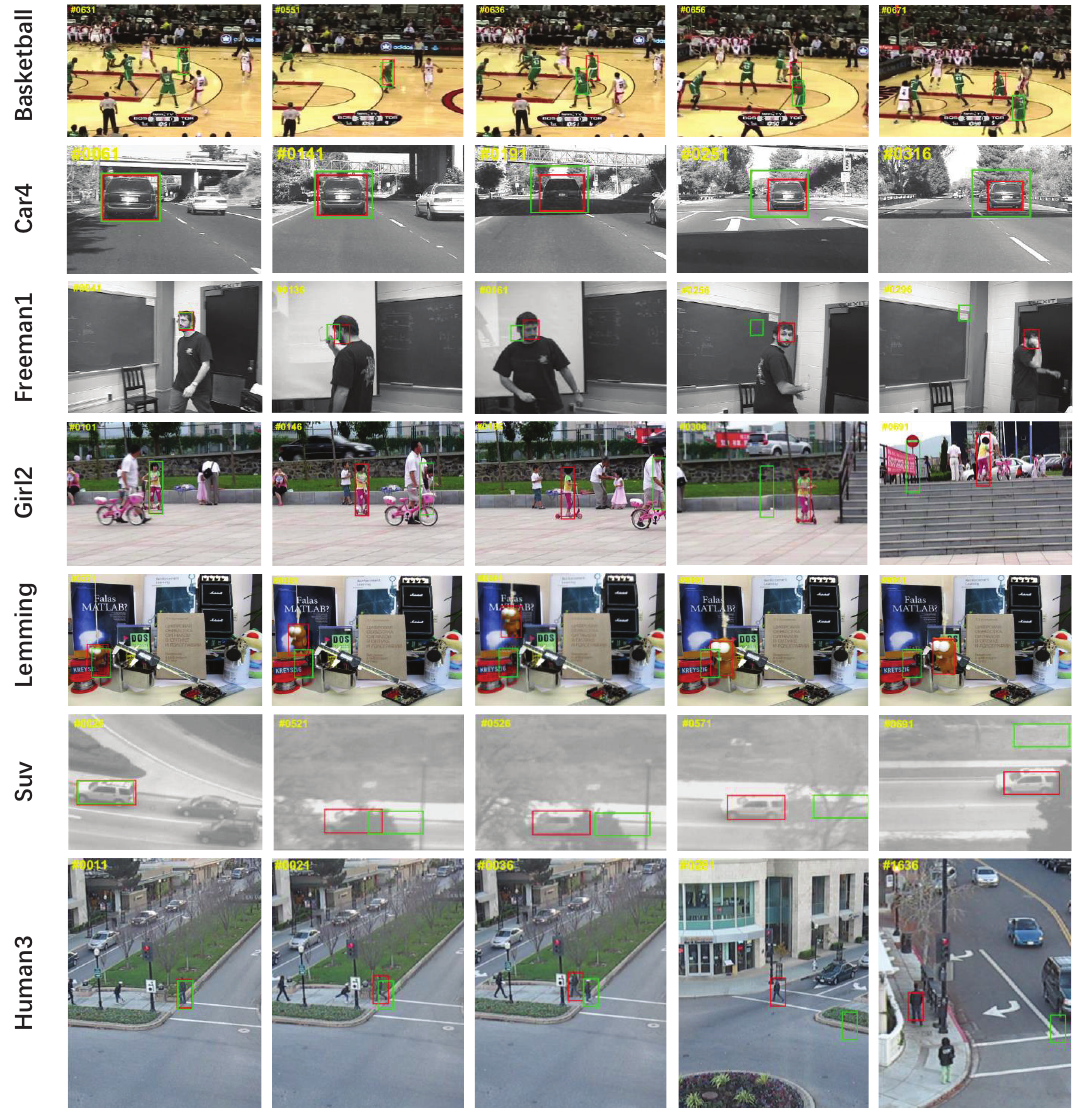
Figure 4. The visualization of the results from our tracker and SOWP [10] on several challenging sequences from OTB-100. The red bounding box is ours, and the green is